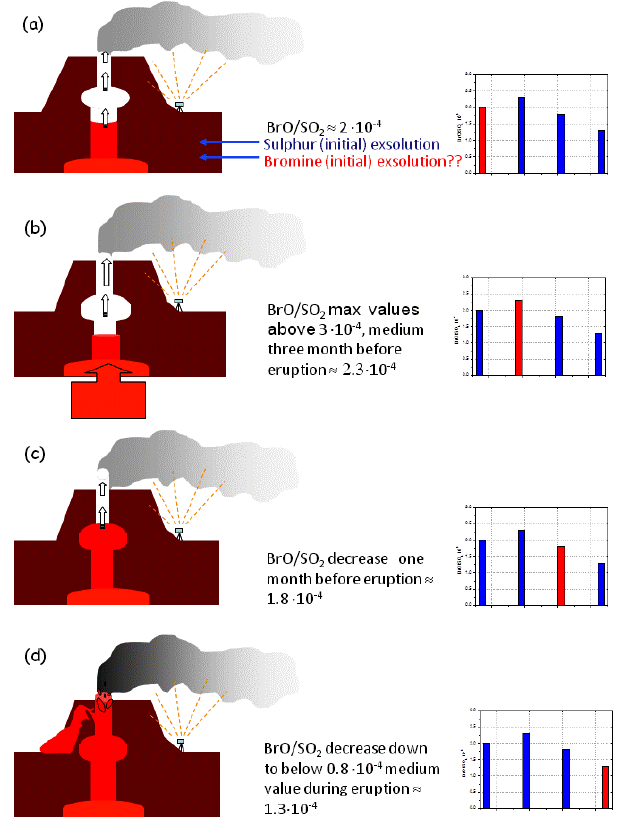
Fig. 7. Sketch of the empirical model. (a) In contrast to chlorine and fluorine, we assume that bromine is less soluble in the mag- matic melt than sulphur. The mean value of non-eruptive periods during 2006–2009 is around 2 × 10 − 4 . (b) Assuming bromine is less soluble in magmatic melt than sulphur, bromine starts to be released earlier in comparison to sulphur when fresh magma is ris- ing up – maxima BrO/SO 2 ratios rise over 3 × 10 − 4 . The mean value is around 2 . 3 × 10 − 4 in month three before the 2006 and 2008 eruptions as well as in month three and two before the two violent lava fountaining events in 2007. (c) When magma is rising further, sulphur starts to be released and might overtake bromine; BrO/SO 2 ratios decrease (SO 2 fluxes should increase). The mean BrO/SO 2 value of the last month before the observed eruption is 1 . 8 × 10 − 4 . (d) Further decrease – no further magma rise from be- low, and melt already depleted in bromine; sulphur out-gasing is determining the ratio. The lowest BrO/SO 2 value during eruptions observed was 0 . 47 × 10 − 4 . The mean BrO/SO 2 ratio was calcu- lated at 1 . 3 × 10 − 4